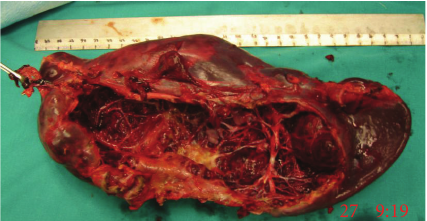
Figure 6: The surgical specimen after total splenectomy containing the spleen and the cystic remnant. The trabecular architecture characteristic of a nonparasitic congenital splenic cyst and the intact spleen are clearly